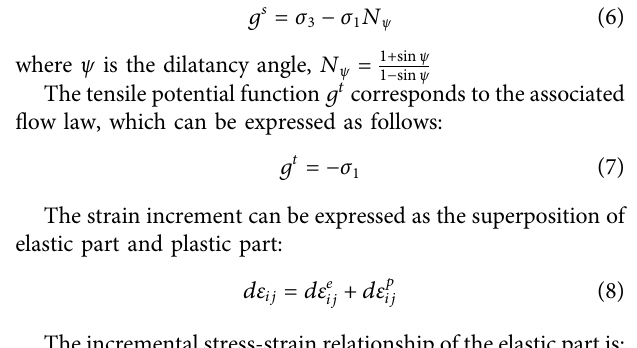
FIGURE 7 | Comparison diagram of calculated displacement and detected